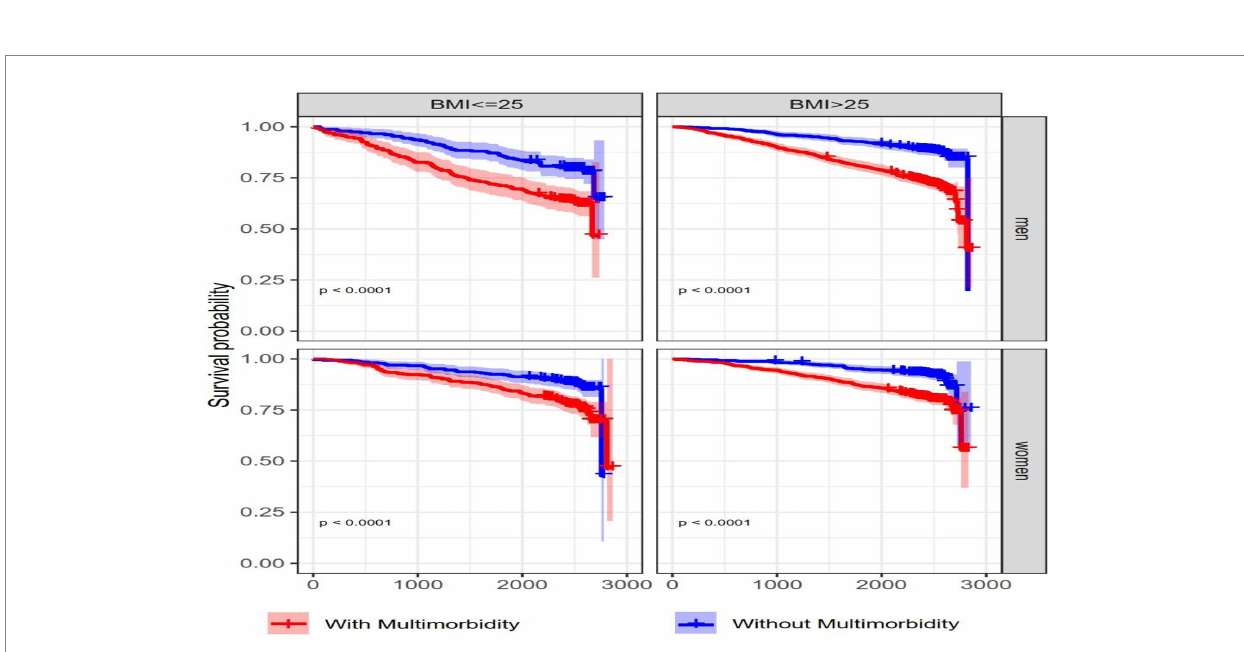
FIGURE 3 Kaplan–Meier survival curves for men and women based on BMI and multimorbidity status. Kaplan–Meier curves show the comparison of survival probability between individuals with and without MM stratified by BMI category (<=25, >25) and sex. p -value <0.0001 are presented for the log-rank